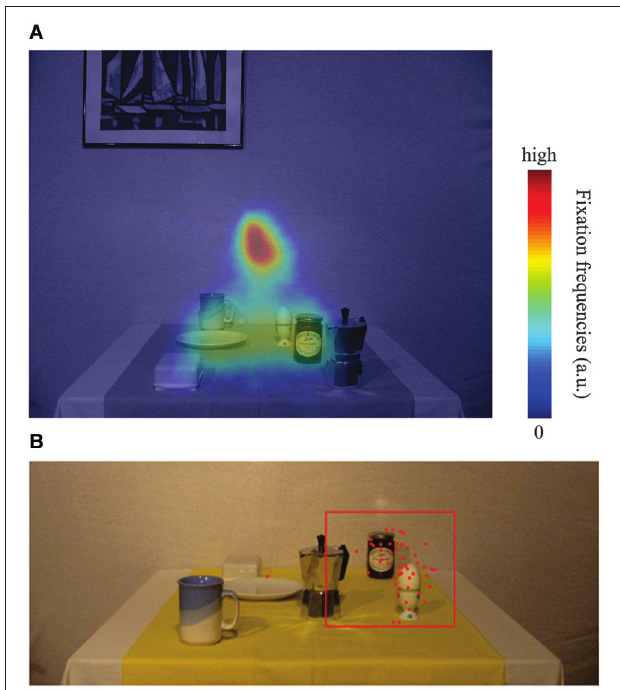
FIGURE 3 | (A) Heatmap of relative fixation frequency during the encoding phase plotted against an example encoding image. Blue colors denote few or no fixations, whereas red colors denote many fixations in that region. (B) Typical example plot of reaching endpoint towards the egg in one of the 18 configurations. Red dots are reaching endpoints from individual trials (local + global). The red square represents the outlier criterion of 2.5 SD relative to the mean reach endpoint in the control condition. All data within the red square have been considered for data analysis, data points outside have been treated as